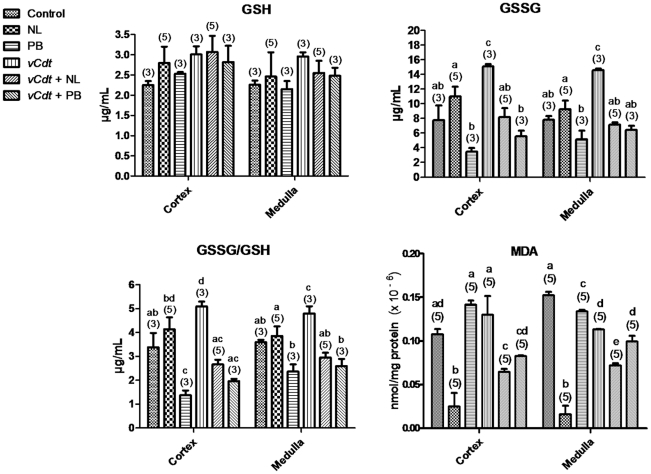
Effects of treatments on renal oxidative stress.Reduced glutathione (GSH), oxidized glutathione (GSSG) and malondialdehyde (MDA) were measured in renal cortex and medulla from mice treated with vehicle (control), allopurinol (NL), probenecid (PB) and Crotalus durissus terrificus venom (vCdt) followed by NL (vCdt+NL) or PB (vCdt+PB) after 2 h. Values are means ± SEM. Number of animals in parentheses. Comparison of the same parameter among groups: ANOVA (cortex: GSH, p = 0.6489; GSSG, p<0.0004; GSSG/GSH, p<0.0001; MDA, p<0.0001; medulla: GSH, p = 0.8440; GSSG, p<0.0001; GSSG/GSH, p<0.0009; MDA, p<0.0001). Post hoc Student-Newman-Keuls (different letters over the bars indicate statistical differences: p<0.05).